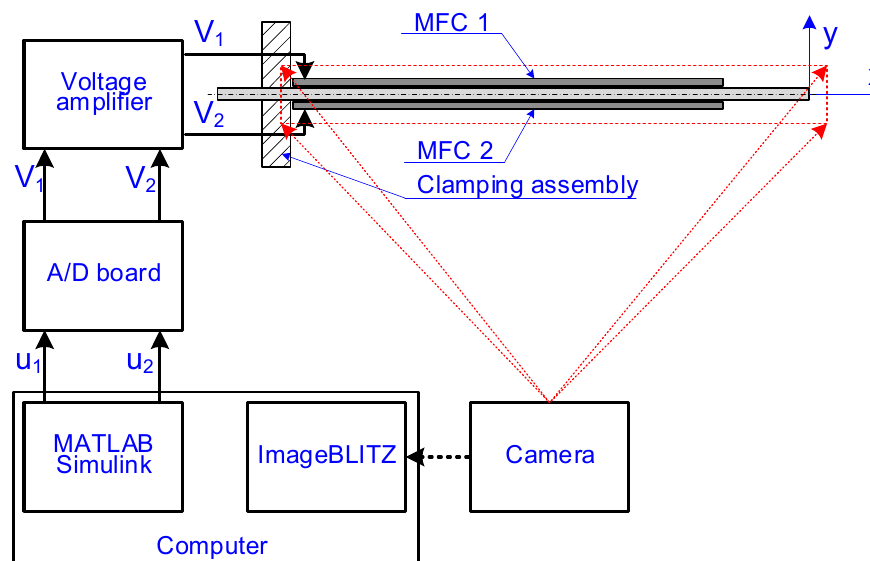
Figure 4. Schema of laboratory stand.